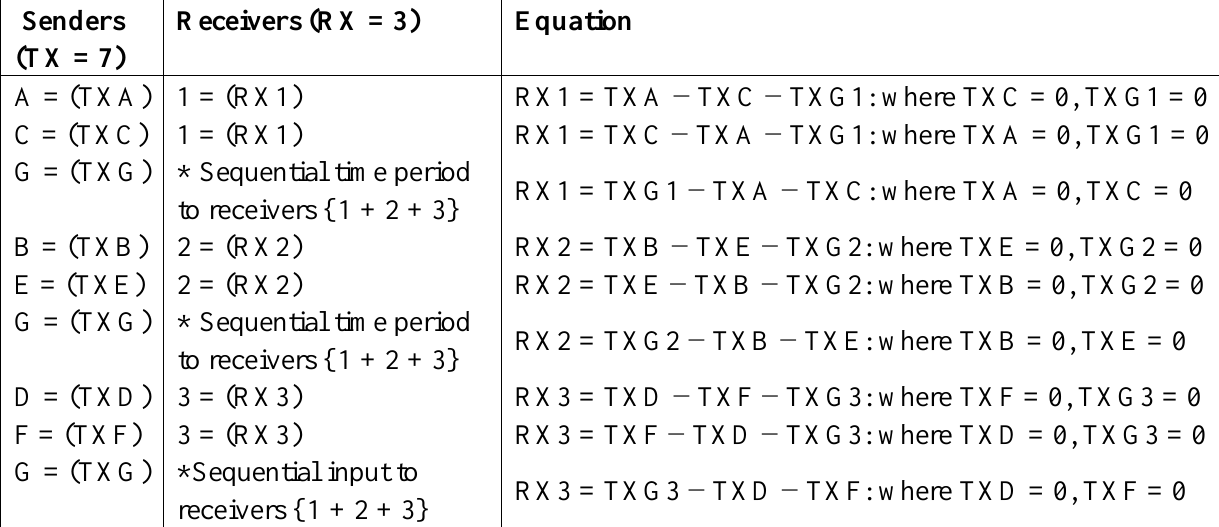
Table 4 equations yield the same outcome as Table 3 but have been expressed differently. Table 4. Equation for uneven sender to multiple radios at sink node on three non-overlapping